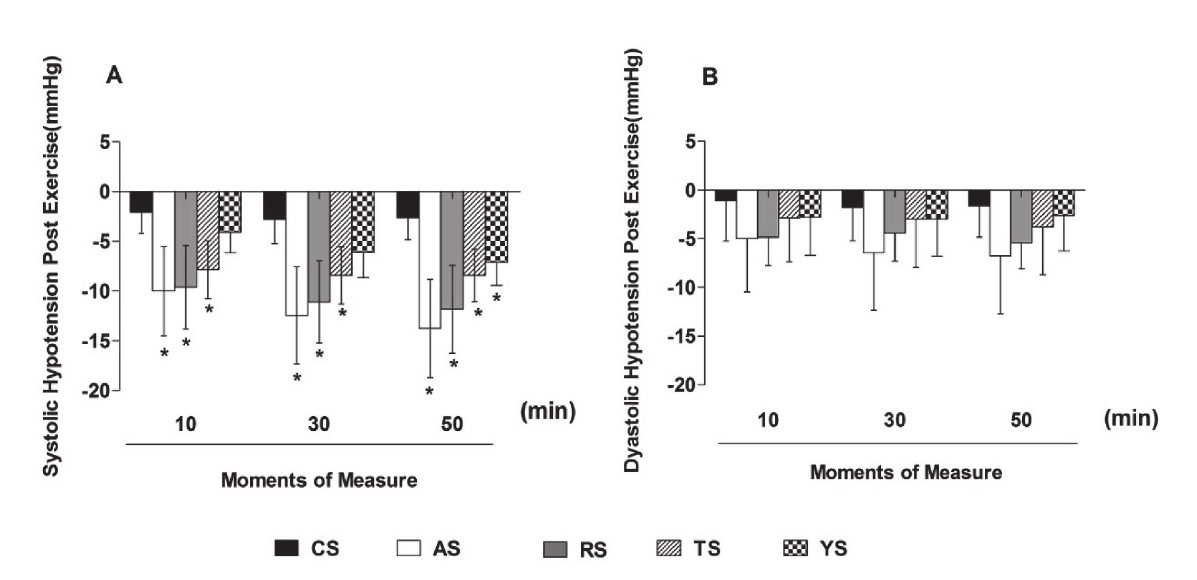
Figure 4 - It shows the values of post-exercise hypotension of the sessions. Note:*statistical difference between the time of measurement of heart rate during exercise, and their resting values. Signi fi cant difference with value of p <